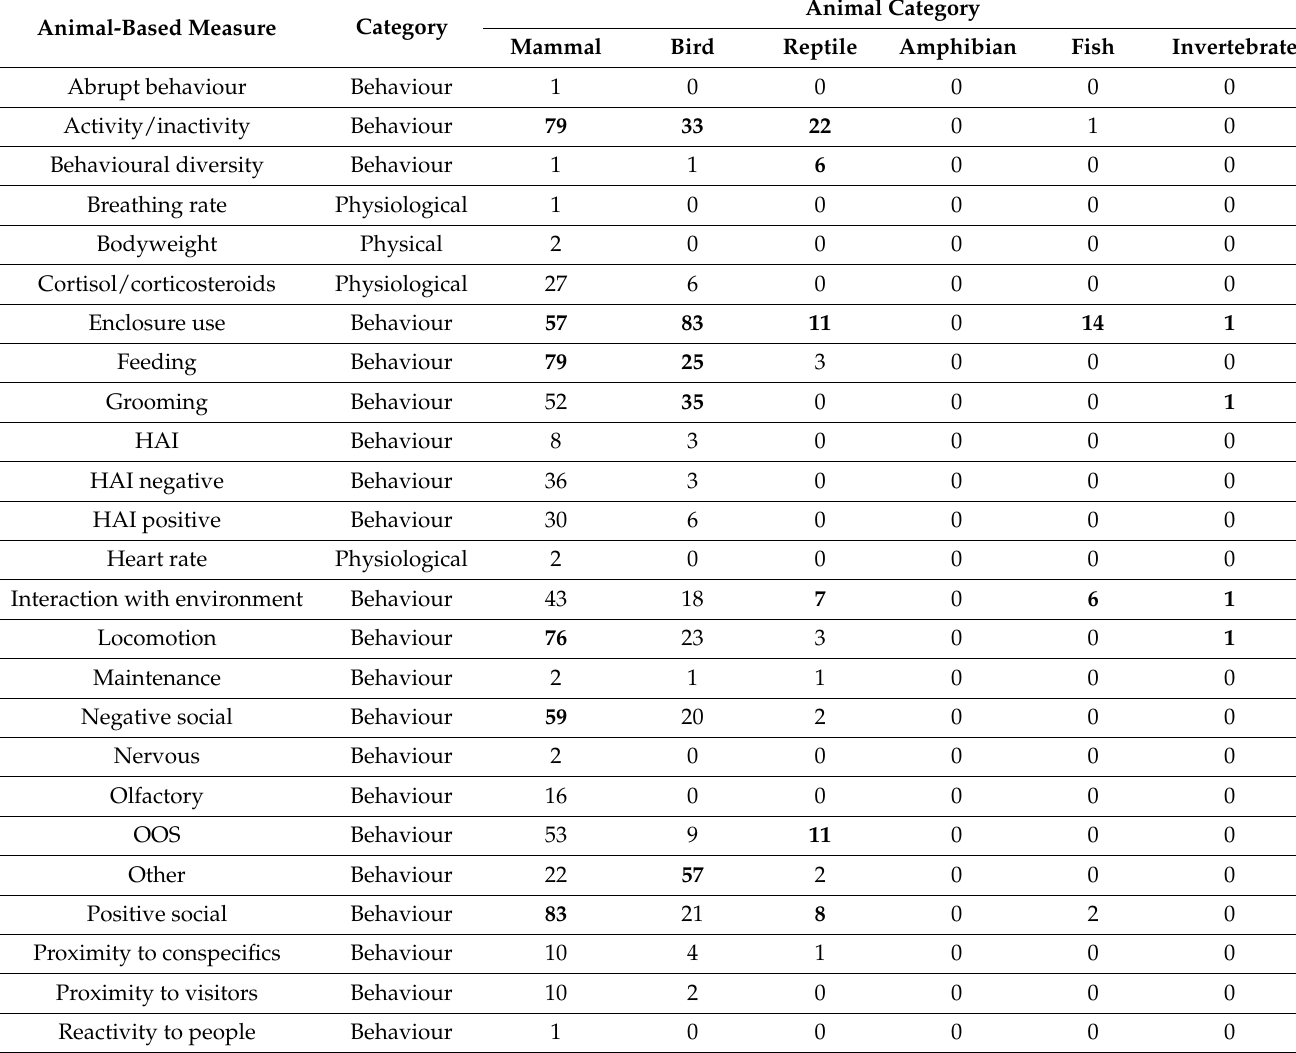
Table 1. An overview of animal-based measures by animal category (total number per paper, including where measures were used more than once to compare against multiple visitor variables. Total number = 1795). The most frequent measures (accounting for >5% of total recordings for that animal type) are displayed in bold.